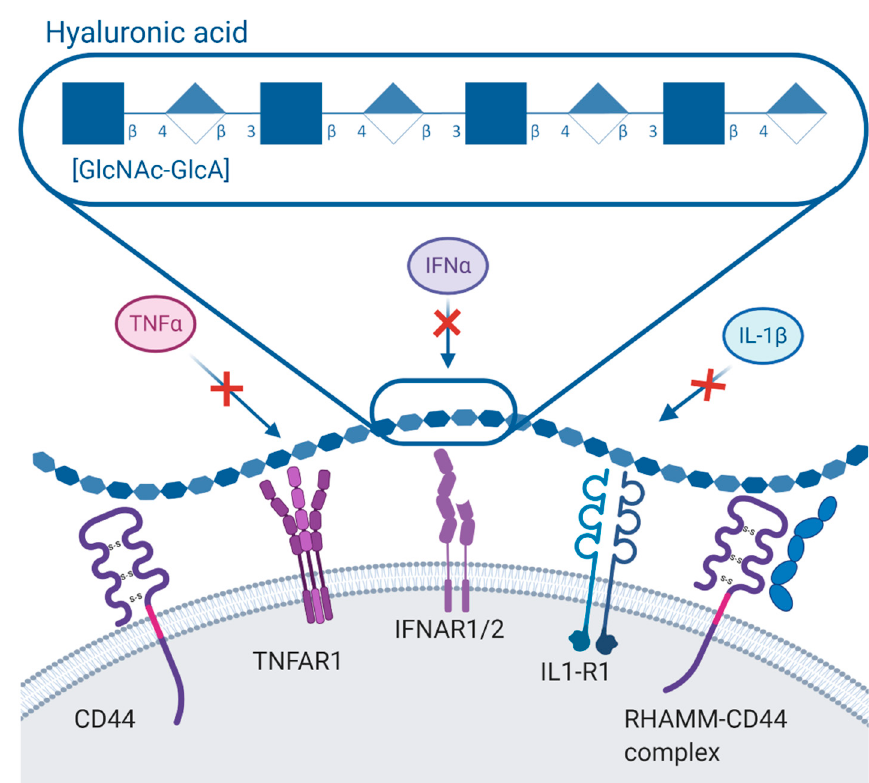
Figure 3. The anti-inflammatory role of hyaluronic acid (HA). HA molecule (on the top) is represented according to its international symbols by repeated units of glucuronic acid (GlcA- β 1-3) and N-acetylglucosamine (GlcNAc- β 1-4) disaccharides. The anti-inflammatory role of HA is mediated through reacting with its several receptors such as CD44 and receptor for HA-mediated motility (RHAMM) preventing the cascades signalled by inflammatory cytokines such as IFN α , TNF α and IL1 β through deterring the contact with their receptors.